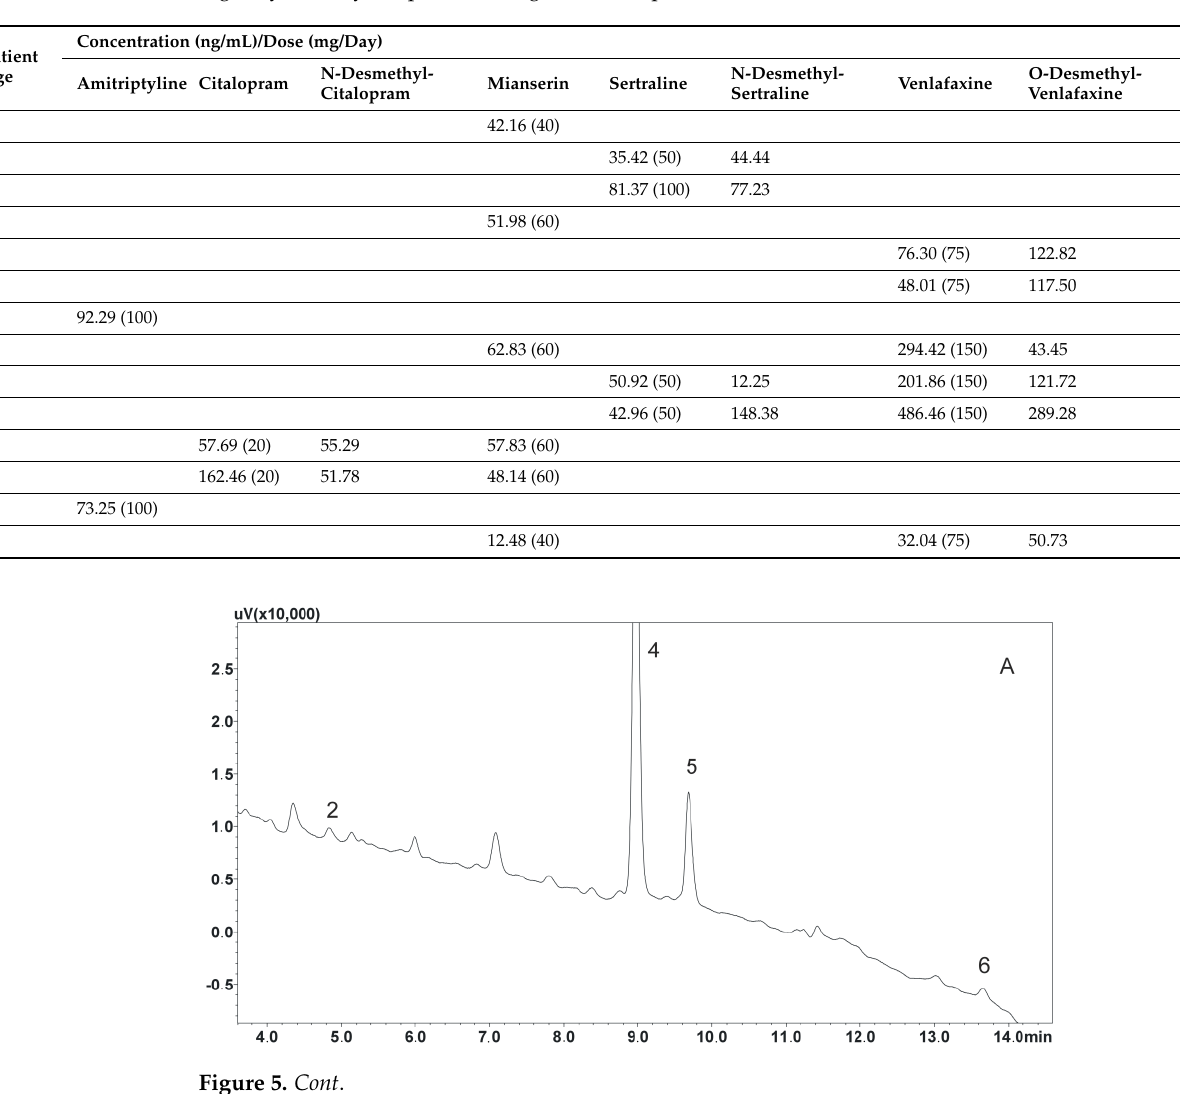
Table 4. The concentrations of antidepressants and their metabolites in saliva samples (drug doses in mg/day used by the patients are given in the